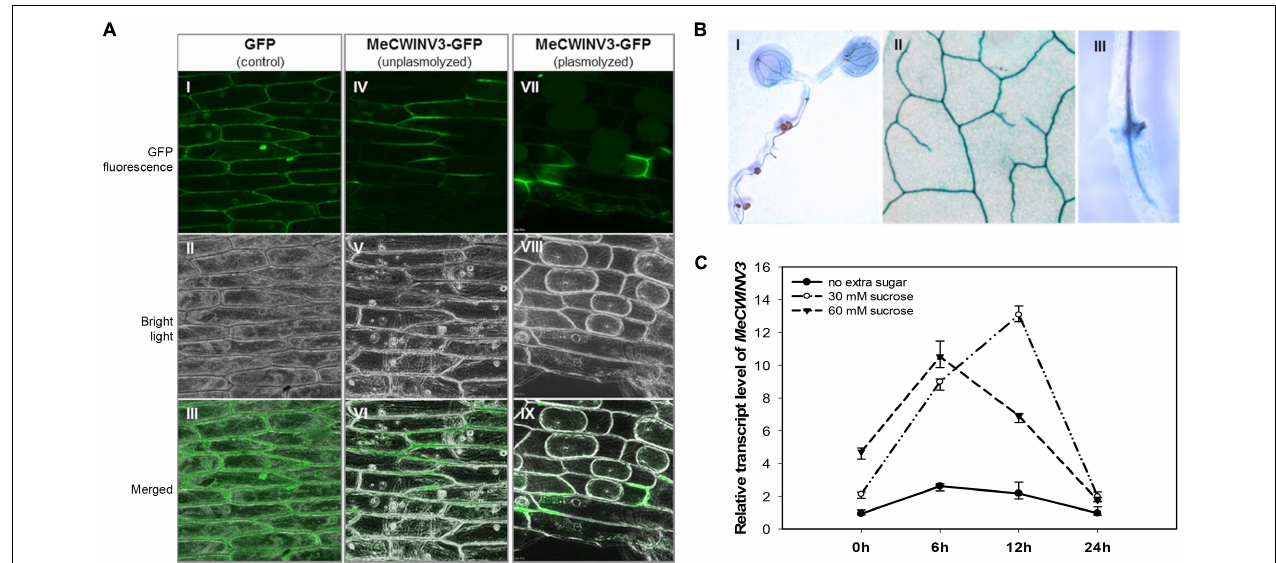
FIGURE 1 | Localization and expression pattern of MeCWINV3. (A) MeCWINV3-GFP fusion showed cell wall localization in onion epidermis cells (I–III, GFP control; IV–VI, unplasmolyzed; VII–IX, plasmolyzed). (B) GUS assay showing MeCWINV3 promoter activity in the vascular bundle of transgenic Arabidopsis, (I, seedling; II, leaf; III, root). (C) Transcriptional response of MeCWINV3 in hydroponic seedlings under 30 and 60 mM sucrose treatments in cassava